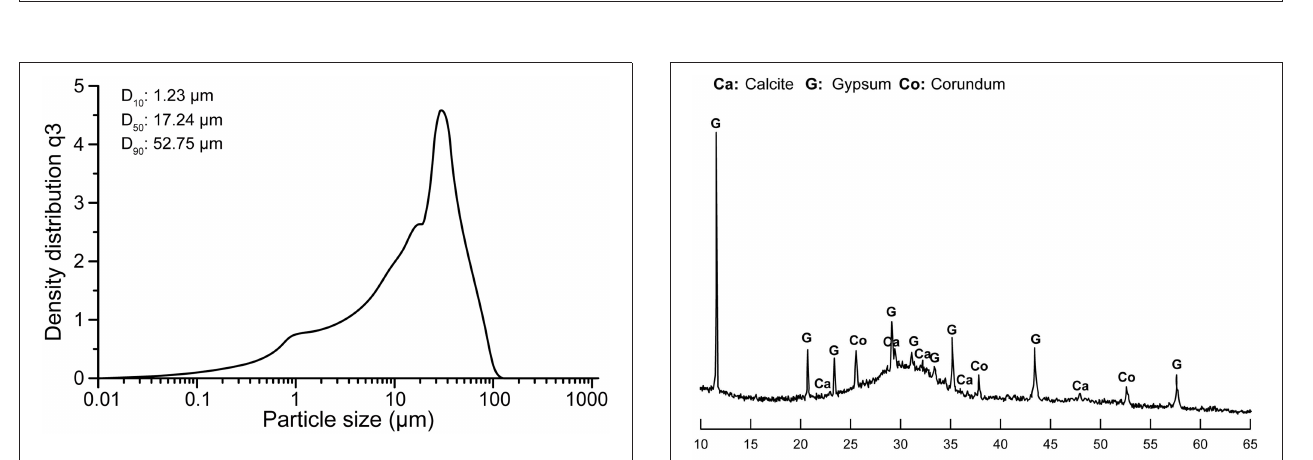
dissolving NaOH and KOH flakes, respectively in tap